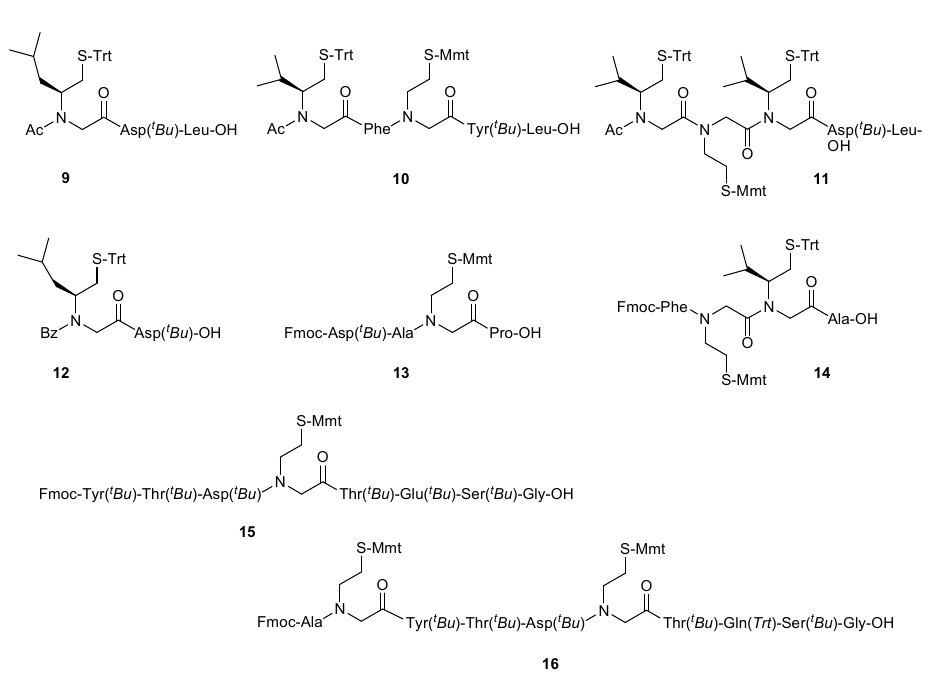
Figure 2. The synthesized S -Mmt / S -Trt / t Bu-protected peptide–peptoid hybrids. Table 1. Retention time (t R ), yield of the crude product (%), HPLC purity of the crude products (%), m / z (calculated and found) of the peptide–peptoid hybrids 9 – 17